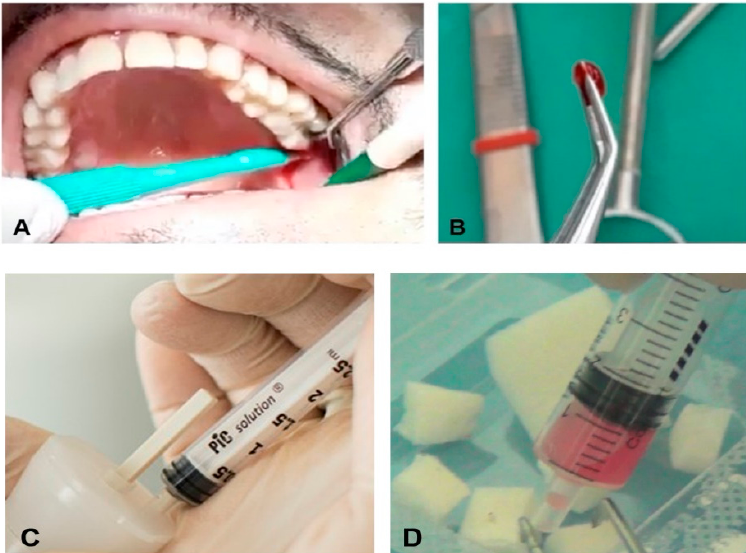
Figure 1. Schematic representation of Rigenera ® technology use. ( A ) Collection of an autologous sample. ( B ) Average size of the tissue sample. ( C ) Mechanical disaggregation with the Rigeneracons ® leads to the generation of micrograft suspensions collected from the device with a syringe. ( D ) The biomaterial is generated by soaking a scaffold with the micrografts.